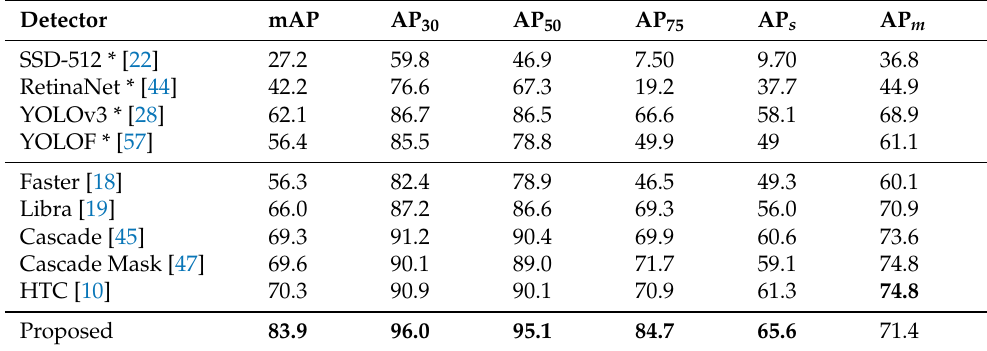
Table 3. Detector testing results. The two-stage detectors use the HRNetV2p backbone. The single- stage detectors denoted with * use their respective backbones. Proposed denotes HTC with OHEM sampler and augmentation training. The best result in each column is in bold.